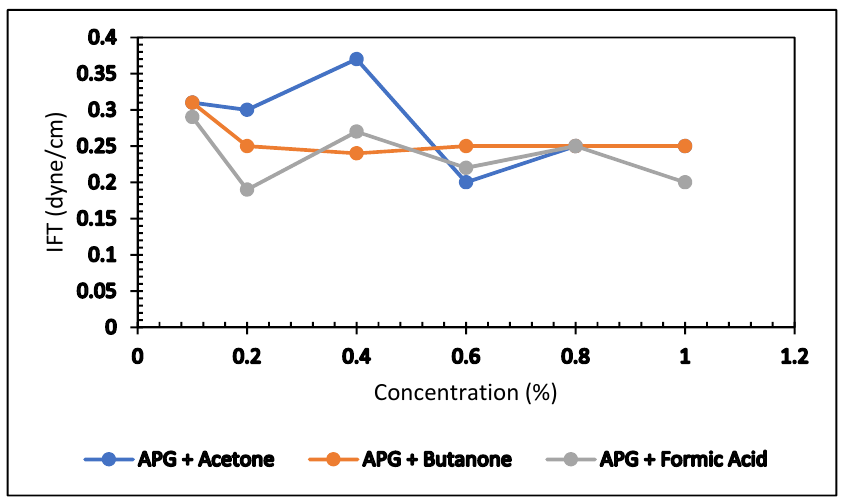
Figure 11. Comparison of IFT values. Table 5. IFT values of formic acid, acetone, and butanone with 0.5% APG and 2% NaCl. Sample No.